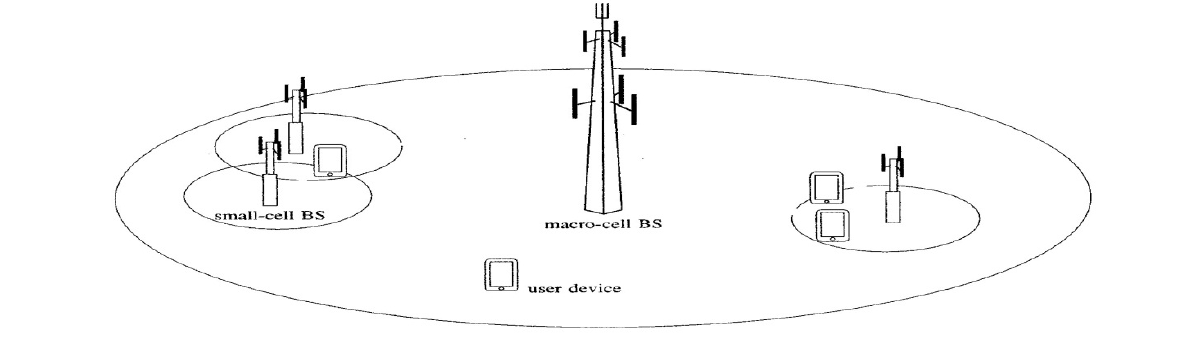
Figure 3. An example of dense small cells systems (after